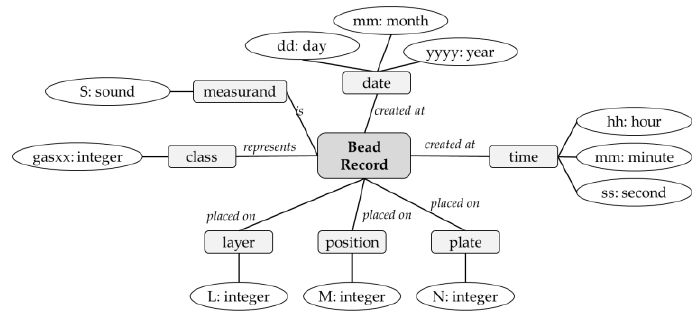
Figure 4. Ontological model for the acquired data samples. Data augmentation was implemented by slicing the sound data into two second